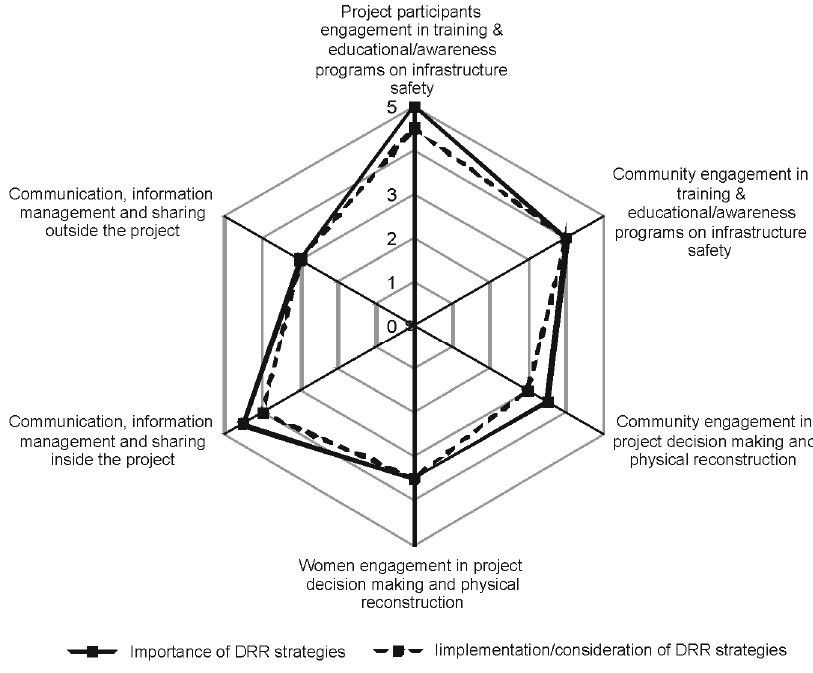
Fig. 3. Comparison of importance of knowledge management strategies and their level of